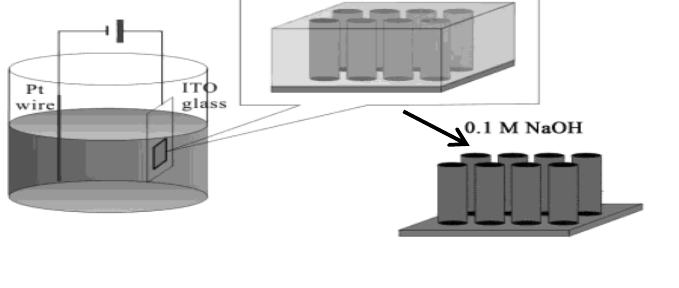
Figure 33. Schematic illustration of the fabricating nanowire arrays of crystalline NMe •[Ni(dmit) ] using a porous alumina template. [Reproduced with permission 4 2 2